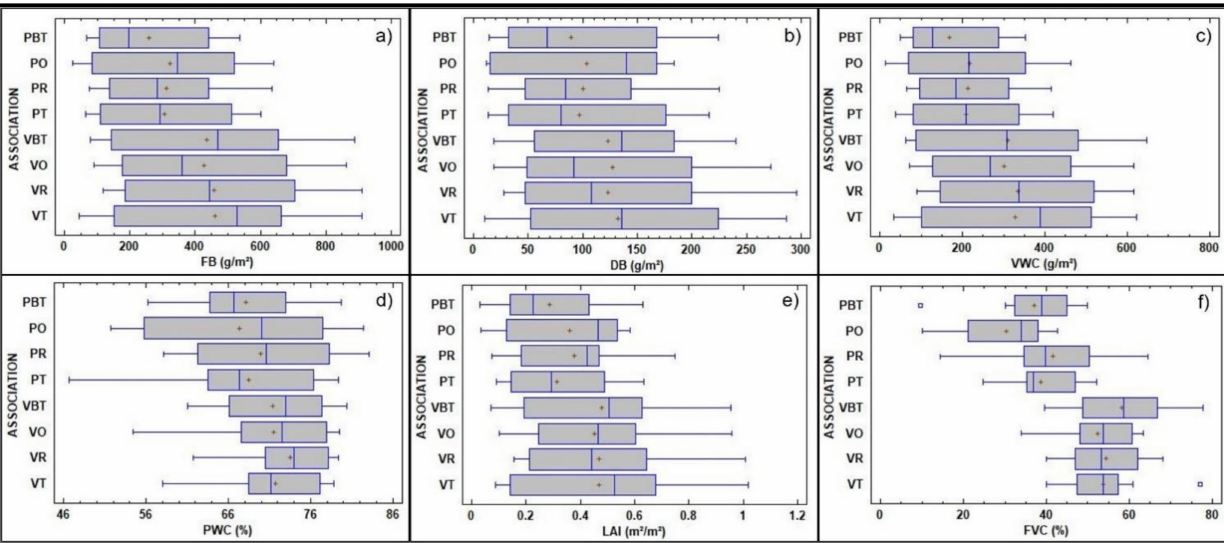
Figure 3. Box-Whisker plots of the in situ parameters for each association. ( a ) FB: fresh biomass, ( b ) DB: dry biomass, ( c ) VWC: vegetation water content, ( d ) PWT: percentage of water content, ( e ) LAI: leaf area index and ( f ) FVC: fraction of vegetation cover; PBT: pea-barley-triticale, PO: pea-oats, PR: pea-rye, PT: pea-triticale, VBT: vetch-barley-triticale, VO: vetch-oats, VR: vetch-rye and VT: vetch-triticale. Mean values are indicated by a red